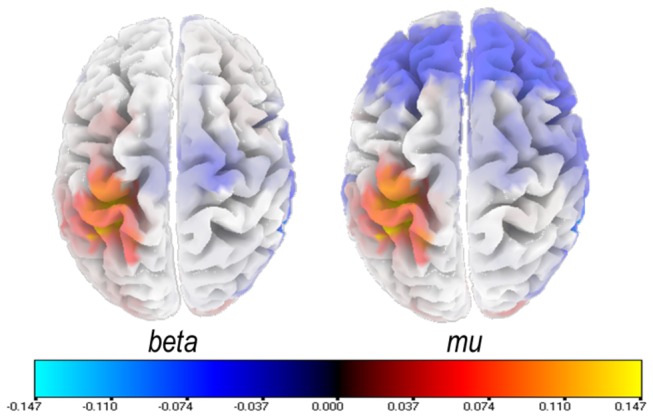
LORETA differences between vocal and non-vocal melodies during the perception epochs in mu and beta frequency bands.Statistical non-parametric current density maps. Color code indicates log of F-ratios. Positive values (red) indicate larger ERD for vocal compared to non vocal.Note that stimuli acoustical features did not explain mu and beta ERD. Indeed, we computed for each vocal stimulus the mu and beta power values, averaged across subjects over the fronto-central region. We then ran separate multiple regressions for mu and beta measures including as predictors: jitter, shimmer, f0 variation and median note duration for each male or female sung melody. Results show that these variables did not explain the variance of mu and beta activity: R2 of the multiple regressions did not exceed 0.03, with F(4, 115)<0.9 and p>0.05. None of the 4 factors reached significance individually.